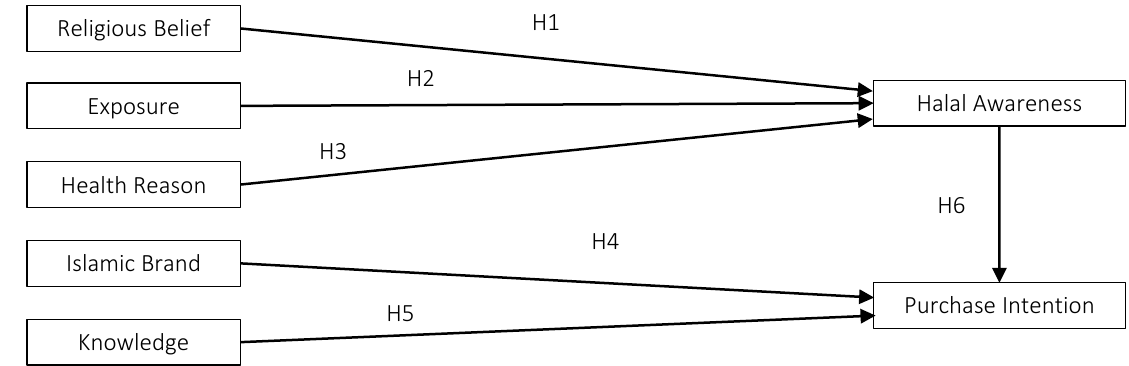
Figure 1. Research